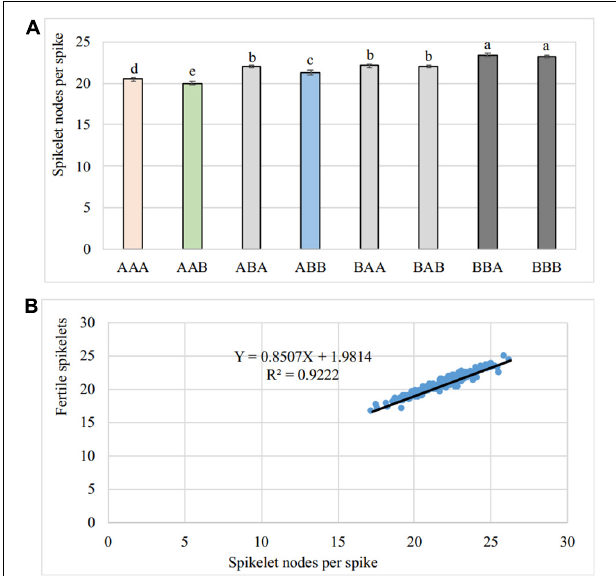
FIGURE 5 | Overall analyses of SNS and fertile spikelets. (A) Comparison of SNS among eight genotypes. These eight genotypes are in the order of WFZP-A1 , WAPO-A1 , and QSns.sxau-7D , with A for the SY95-71 allele and B for the CH7034 allele. The averaged SNS over the six experimental locations were comparisons. A t -test was performed to show significant levels in difference of SNS between the two alleles, with a though e for a significant difference ( P < 0.05). (B) Correlation of SNS and fertile spikelets. The averaged SNS and fertile spikelets over the six experimental locations were analyzed their